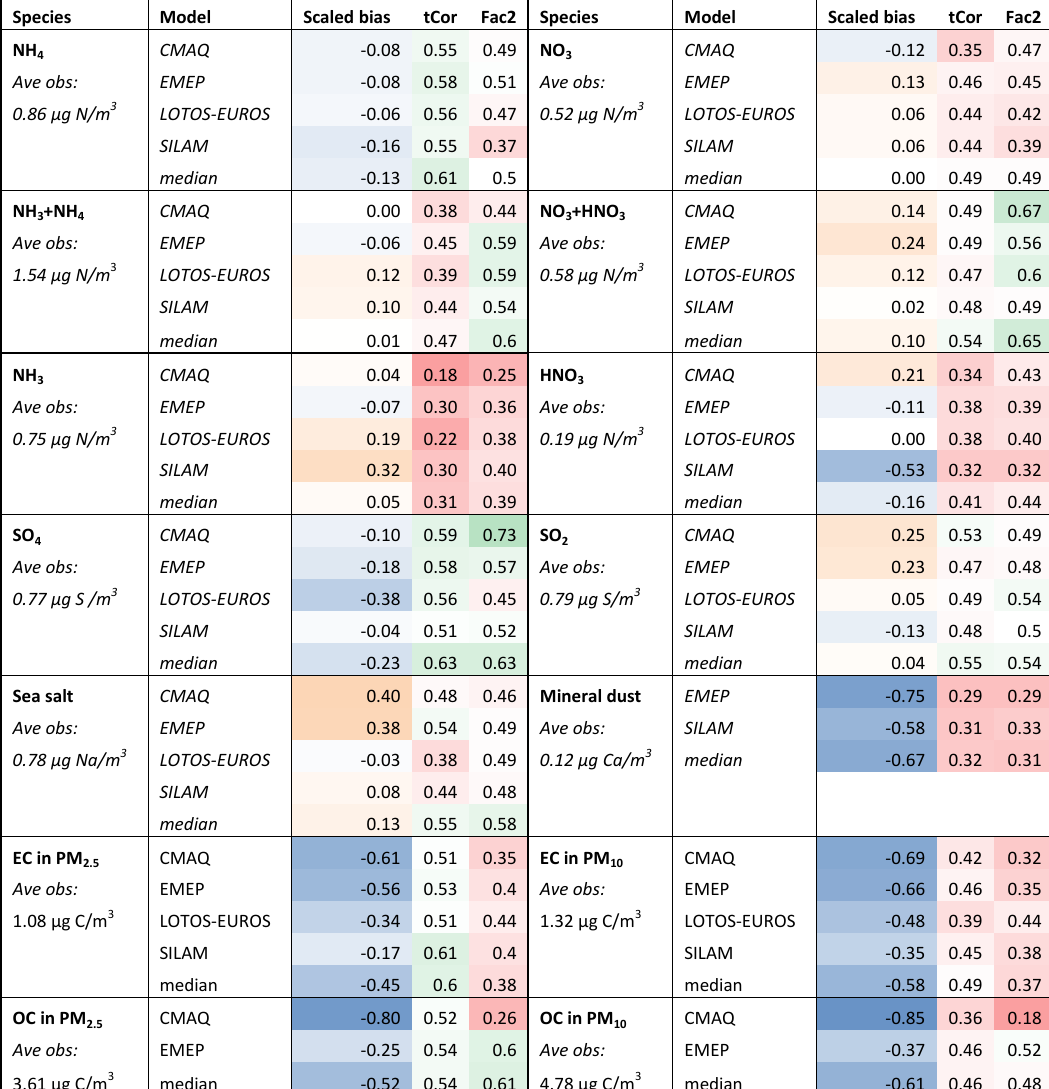
Table 7 Annual statistics for the PM components: ScaledBias - bias divided with the mean observed value, tCor - temporal Table 7. Annual statistics for the PM components: ScaledBias – bias divided with the mean observed value, tCor – temporal correlation of correlation of the daily values, Fac2 – the fraction of daily values within factor of two from the observed ones. The shading the daily values, Fac2 – the fraction of daily values within factor of 2 from the observed ones. emphasizes the range of the